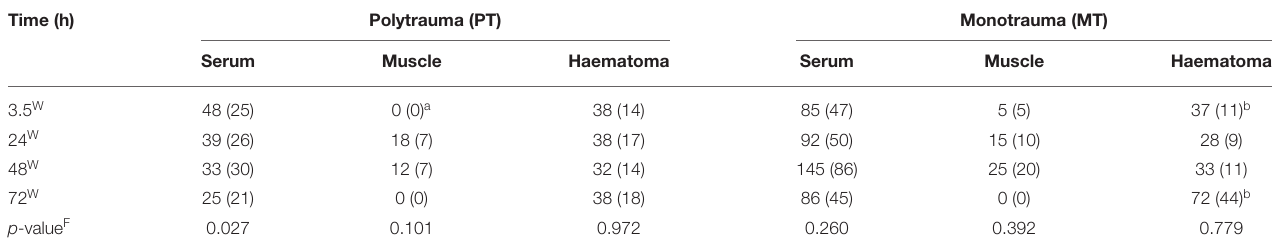
TABLE 3 | Systemic and local concentrations of IL-10 pg/ml; a p < 0.05 compared to serum concentrations, b p < 0.05 compared to muscle concentrations, c p < 0.05 compared to PT. Time (h)